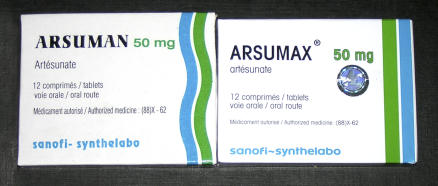
Genuine (Right) and Counterfeit (Left) Arsumax (Artesunate) from Cameroon (Photograph by Manuela Sunjio)Note that the genuine Arsumax bears a hologram from Guilin Pharmaceutical, which manufactures the tablets (see
Figure S1).